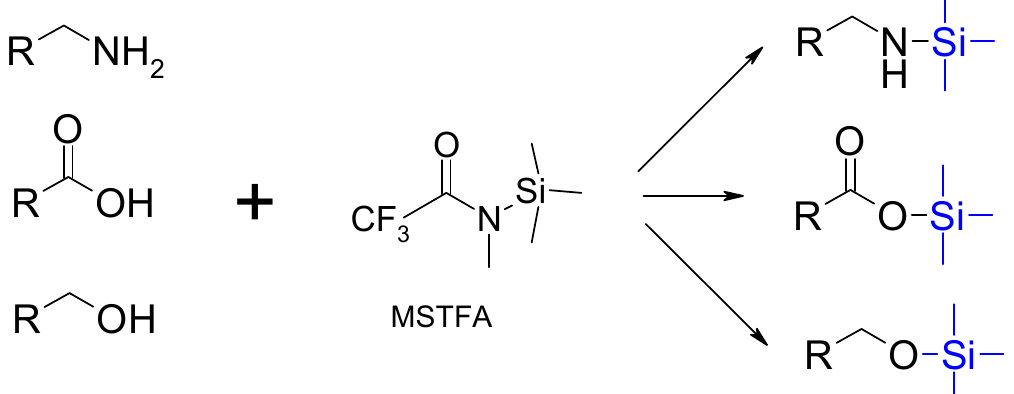
Figure 1. Overall scheme of chemical derivatization of metabolites by silylation using trimethylsilyl derivatives, e.g. N-methyl-N-(trimethylsilyl)trifluoroacetamide (MSTFA). N-methyltrifluoroacetamide leaving group by the